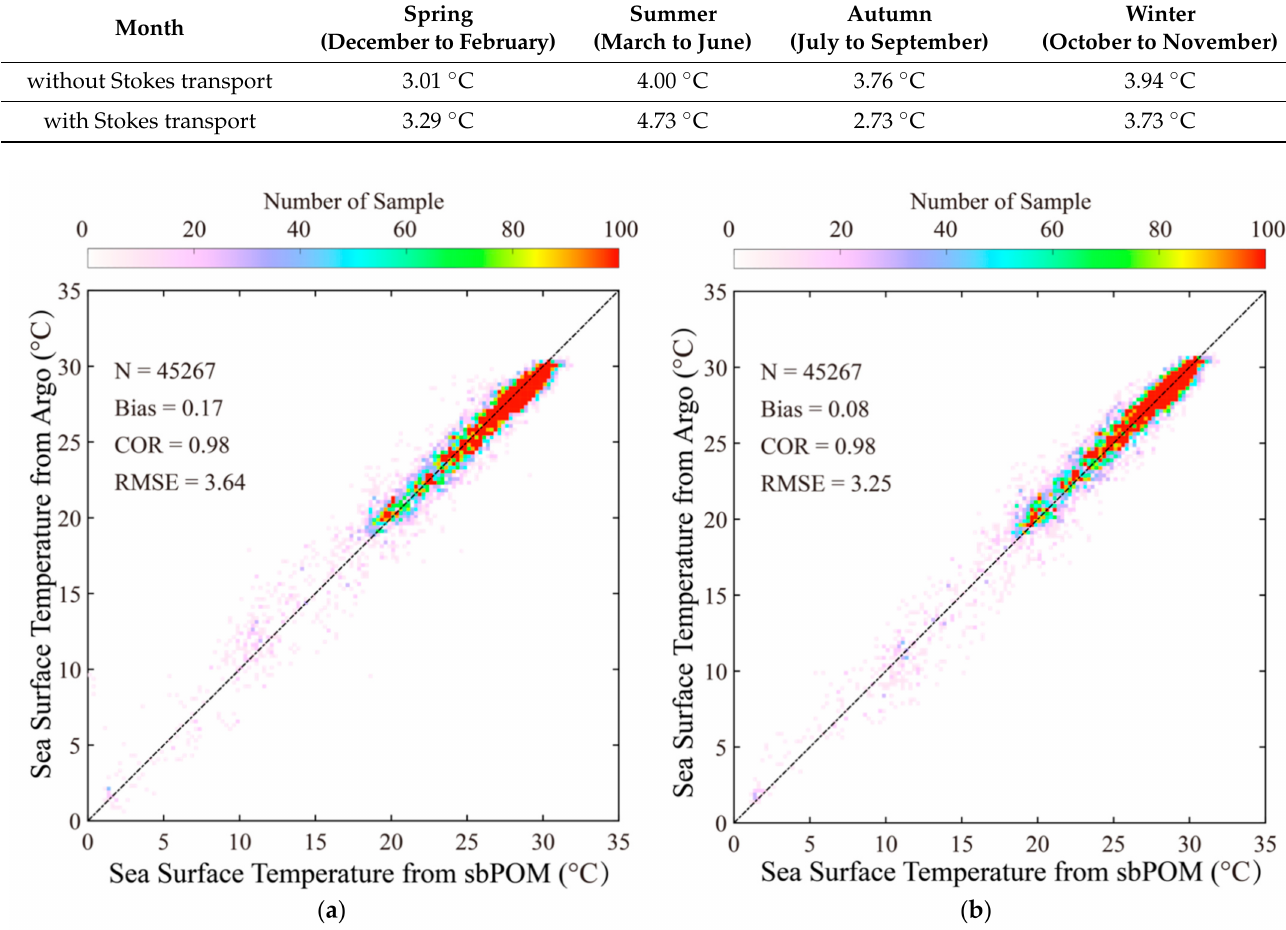
Figure 11. A time series of sea surface temperature from the Stony Brook Parallel Ocean Model (sbPOM) at Argo ID: 2,901,578 (during the period from 30 June to 30 July 2015). Table 2. The root mean square error (RMSE) of seasonal sea surface SST between Argo and the sbPOM in 2015.